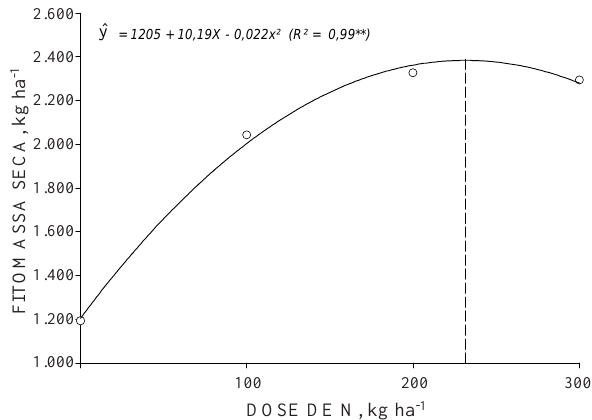
Figura 1. Produção de fitomassa seca de acordo com as doses de N aplicadas no inverno (N-TI) e dose de N (231 kg ha -1 ) que gerou a Máxima Eficiência Técnica, Guarapuava (PR)